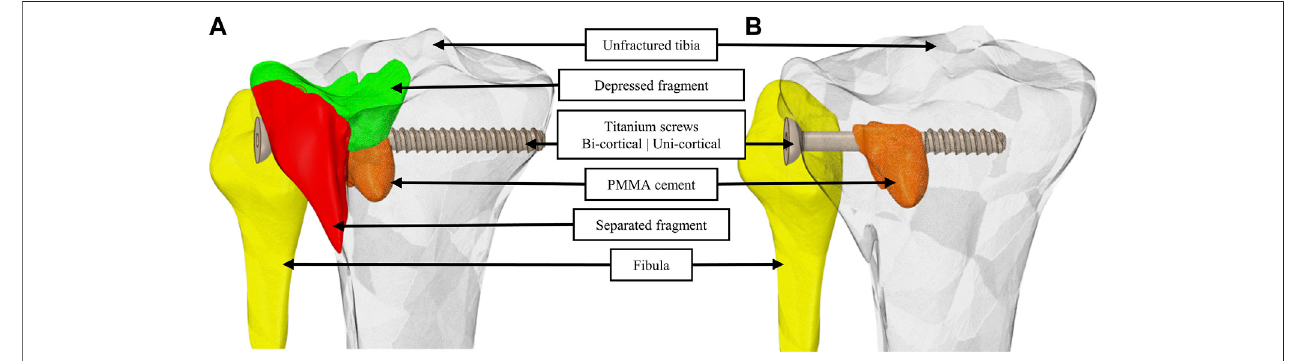
FIGURE 1 | Geometric models with identi fi cation of the separated and the depressed fragments (A) and by considering bone fragments merged into a single geometryandinterfragmentarygaps fi lled (B) .Foravisualunderstanding,abi-corticalscrewisintegratedtothemodelin (A) andauni-cortical screwisintegratedin (B) . PMMA cement is integrated in both (A) and ( B)